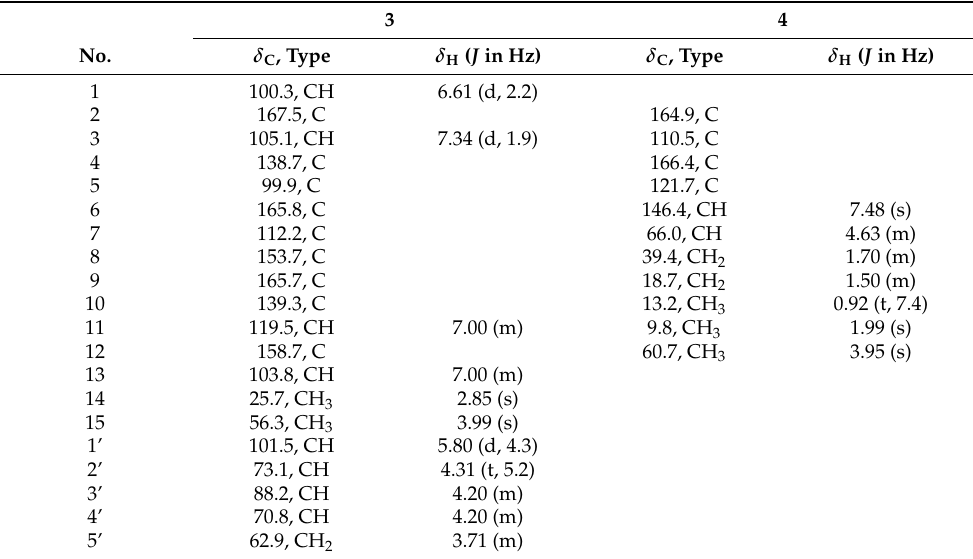
Table 3. 1 H NMR (600 MHz) and 13 C NMR (150 MHz) spectral data of 3 and 4 in acetone- d 6